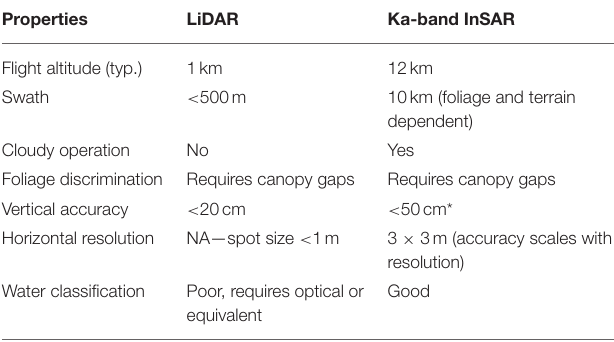
TABLE 2 | Comparing LiDAR and Ka-band